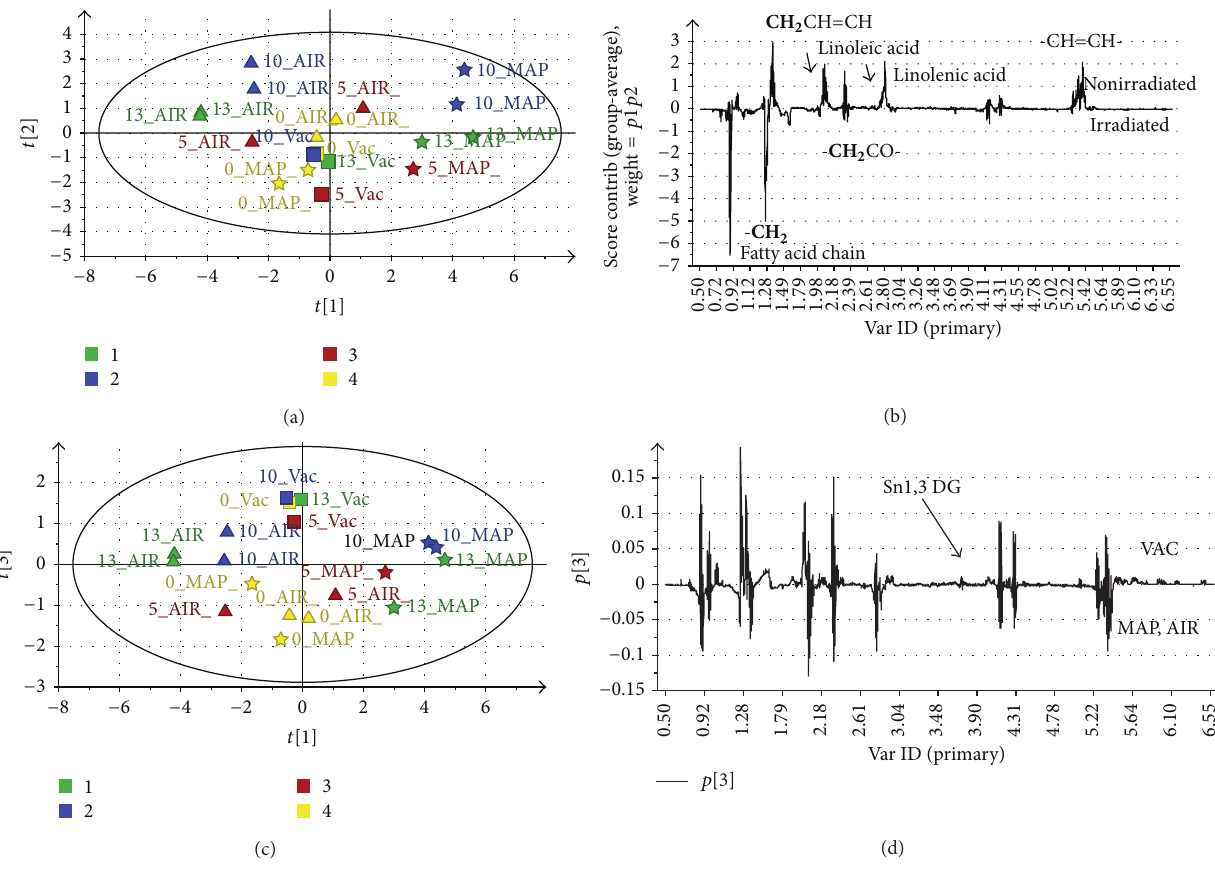
Figure2:(a)PCAmapofthetwofirstPCsonNMRdatausingParetoscalingofthetotalsampleset. 𝐴 = 3 , 𝑅 2 X 1,2 ( :77.5%,and 𝑄 2 X 1,2 ( : cum ) cum ) 70.6%. Samples of MAP, air, and vacuum packages are denoted by a star, triangle, and box, respectively. While yellow, red, blue, and green colors correspond to 0, 5, 10, and 13kGy, respectively, as also denoted by the labels. Only the mean values of each irradiation process are presented. (b) Contribution plot showing the difference between the average of the nonirradiated and irradiated samples. The variables with positive and negative values characterize the nonirradiated and the irradiated samples, respectively. (c) PCA map of PC1 and PC3 on NMR : 61% and 𝑄 2 X 1,3 ( : 70.6%. (d) Loading plot of data of the total sample set. 𝑅 2 X 1,3 ( cum ) cum )